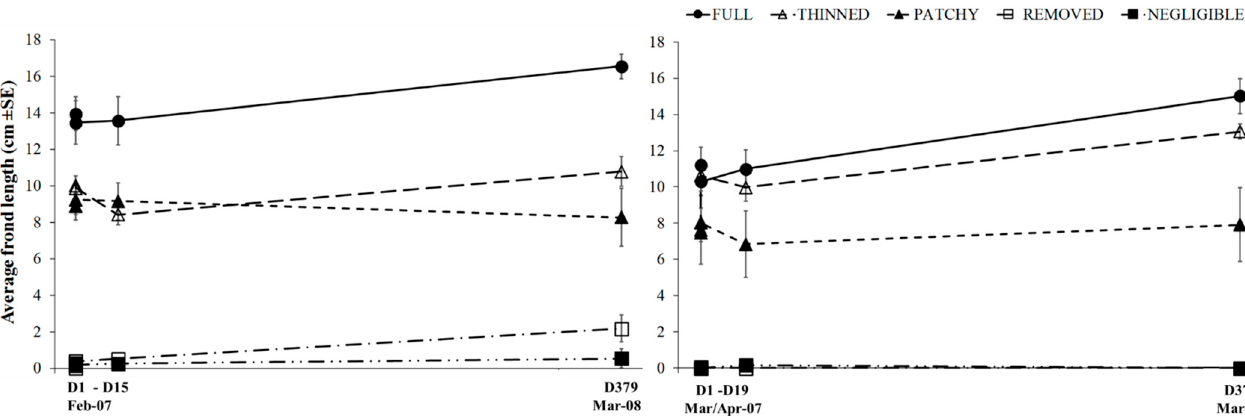
Figure A5. Average Hormosira frond length (cm ± se) between treatments and over time at 13th Beach (left hand side) and Bridgewater Bay (right hand side).